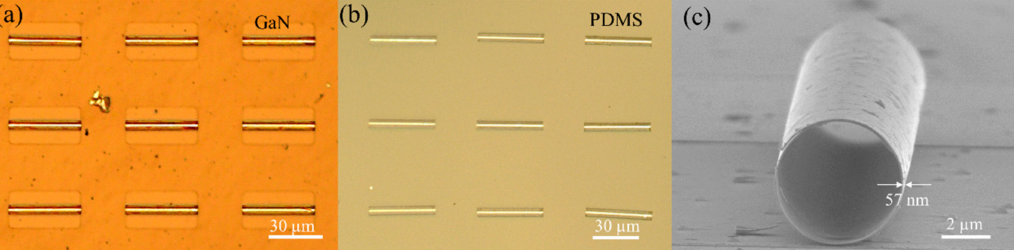
Figure 1. Optical images of ( a ) arrays of microtubes on GaN layers and ( b ) arrays of microtubes in PDMS film. ( c ) Side view of SEM image of microtubes with 57-nm wall